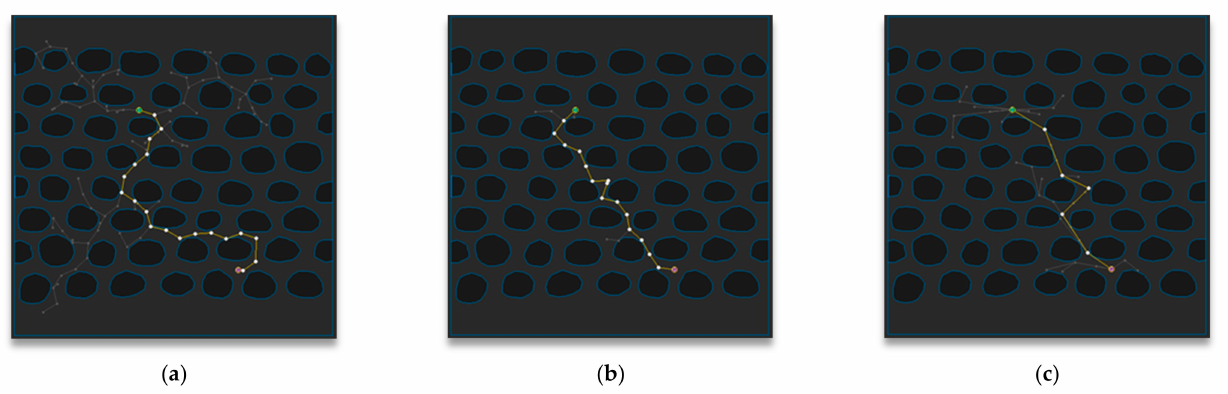
Figure 15. Experimental result of Map 5: ( a ) RRT; ( b ) RRT-Connect; ( c ) the proposed algorithm.